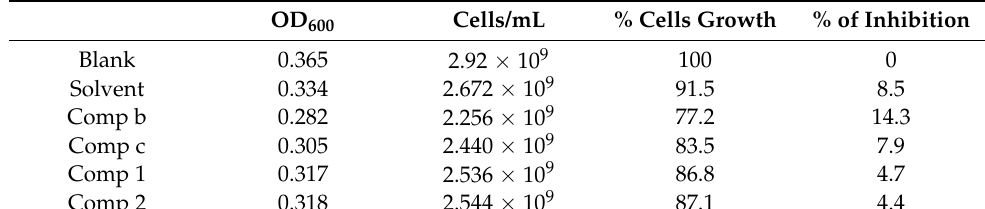
Table 3. Final OD 600 values, the estimated number of cells per ml, and percentages of inhibition for each growth curve.